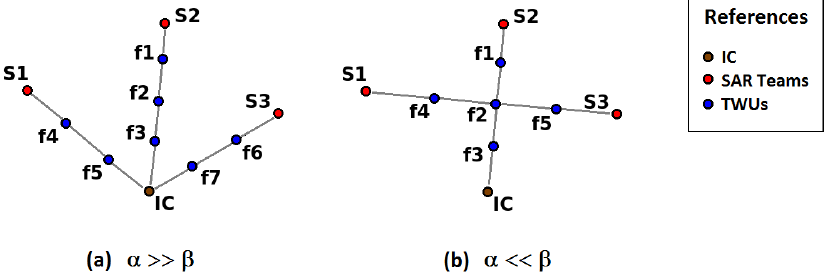
Figure 4. Network deployment situations: ( a ) more nodes using minimal paths and ( b ) less nodes with longer paths. IC: incident